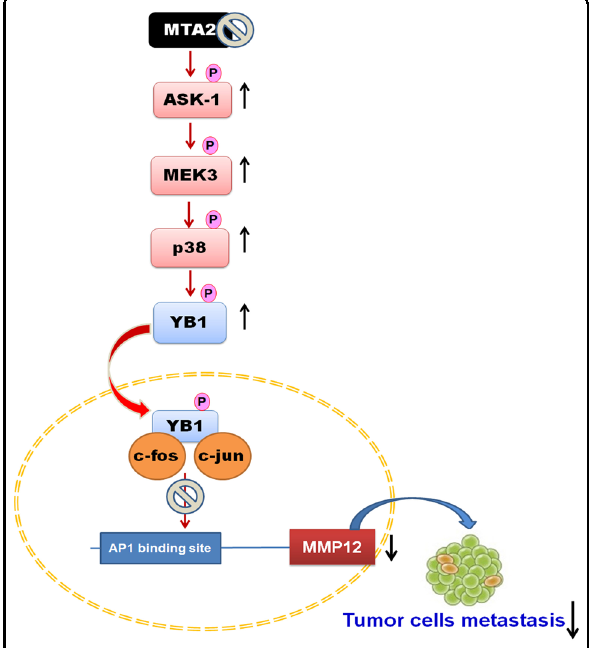
Fig. 7 Proposed mechanism for the MTA2 knockdown attenuating metastatic potential of cervical cancer cell. Our fi ndings indicate that MTA2 knockdown induces activation of the ASK1/MEK3/p38 cascade, which subsequently leads to YB1 phosphorylation and the binding of p-YB1 and AP1, inhibiting AP1 transcriptional activity and MMP12 expression, thereby reducing cervical cancer